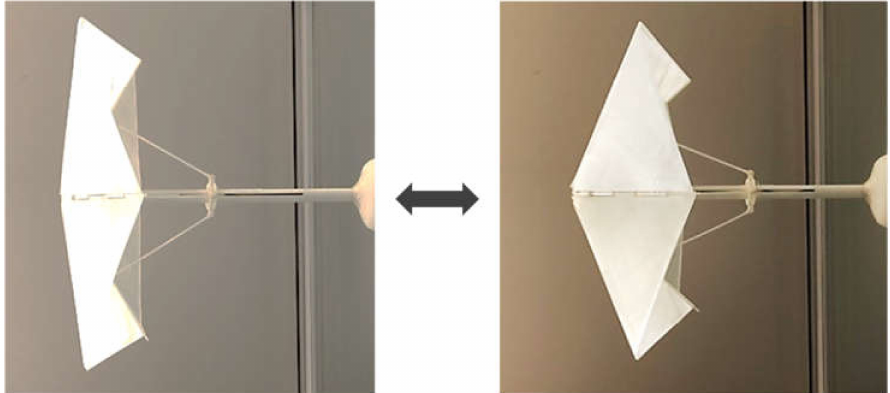
Figure 1. Example of SMA-bias extension spring actuation in architecture: 3D-printed parametric design of SMA-actuated shading